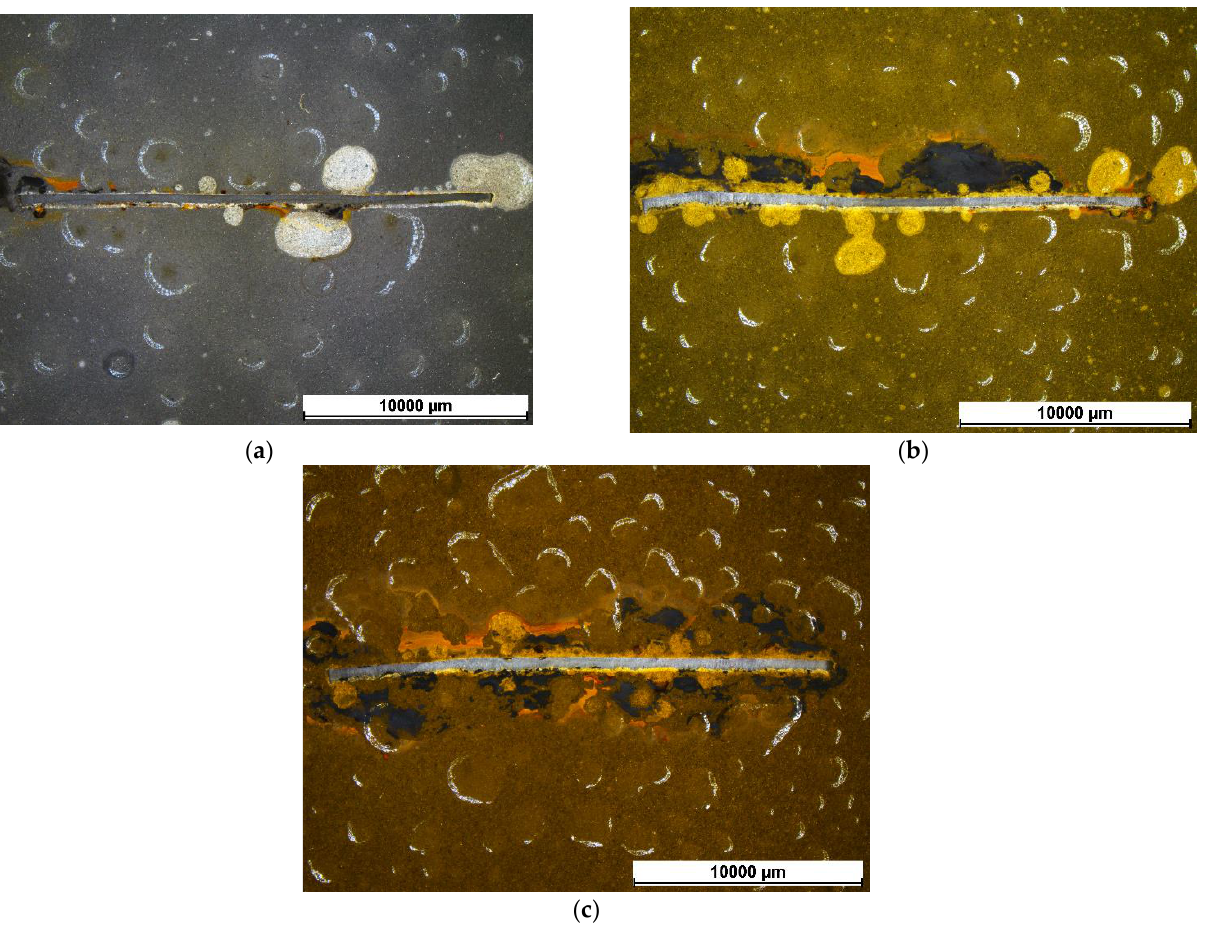
Figure 7. Samples A ( a ), A1 ( b ), and A2 ( c ) appearance after 500 h of exposure in the salt spray chamber.